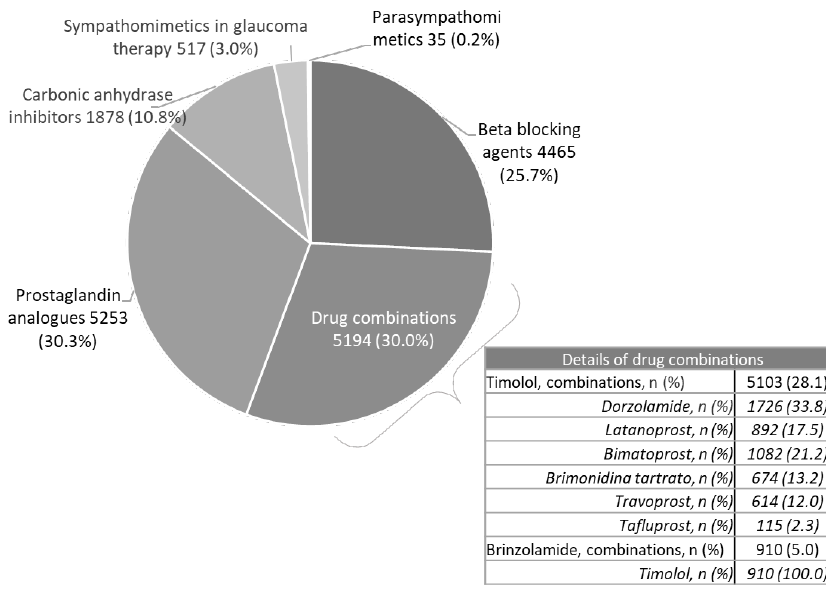
Figure 2. Class of ophthalmic drops treatments at the index date. During all the period analyzed, 11.5% of patients had a trabeculectomy, 2% a trabecu- loplasty. Patients that underwent trabeculoplasty were older compared to those treated with drops only and showed a higher level of comorbidity profile (Table 1). Table 1. Characteristics of glaucoma patients.